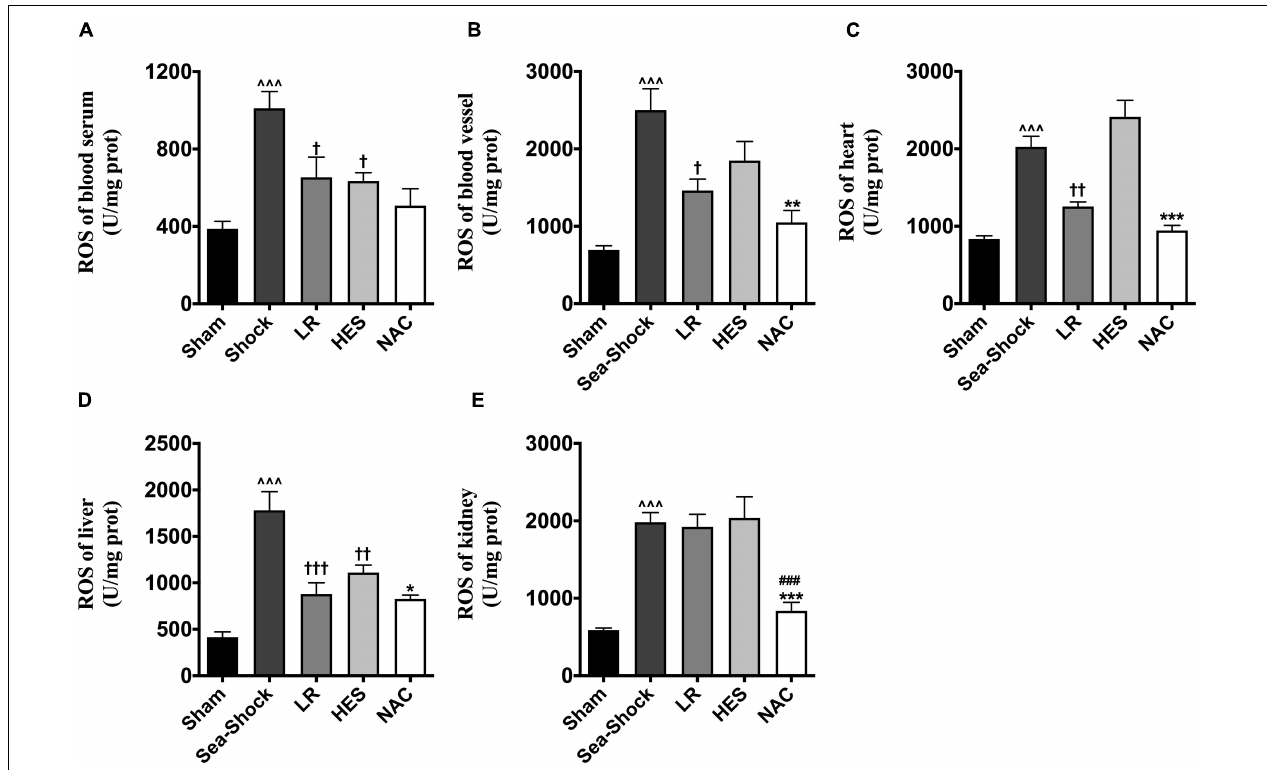
FIGURE 5 | Effects of LR solution, HES solution, and LR solution with the addition of NAC (30 mg/kg) on ROS. (A) ROS of blood vessel; (B) ROS of heart; (C) ROS of kidney; (D) ROS of liver; (E) ROS of lung. LR, Lactated Ringer’s; HES, Hetastarch; NAC, LR solution with the addition of NAC (30 mg/kg). Data presented as mean ± standard deviation ( n = 8/group). ∧∧∧ P < 0.001, Sea-Shock group versus baseline; † P < 0.05, †† P < 0.01, ††† P < 0.001, LR group or HES group versus Sea-Shock group; ### P < 0.001, LR group versus NAC group; * P < 0.05, ** P < 0.01, *** P < 0.001, HES group versus NAC